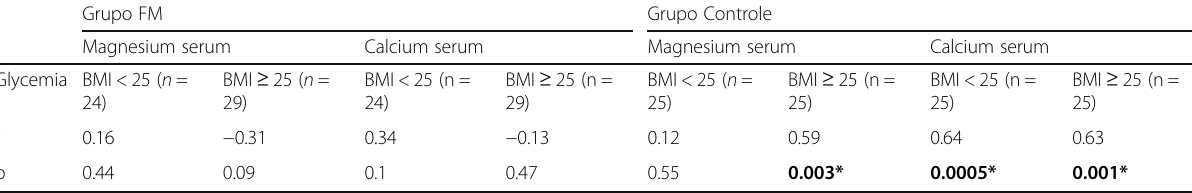
Table 3 Correlation between glycemia and serum magnesium and calcium levels in the groups divided by body mass index (BMI) Grupo FM Grupo Controle Magnesium serum Calcium serum Magnesium serum Glycemia BMI < 25 ( n =